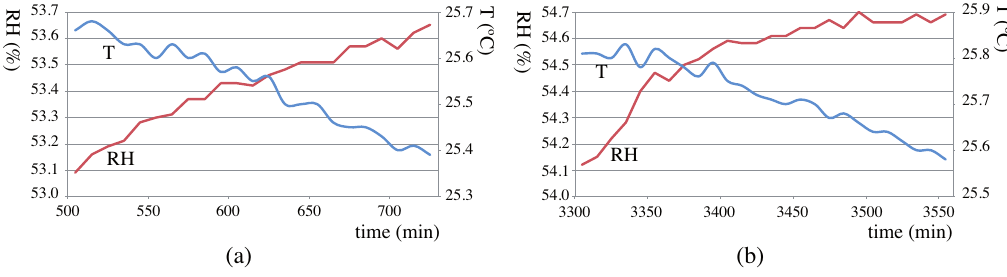
Figure 10. Time segments α ( a ) and β ( b ) from Figure 9 where variation in resistance is almost zero.